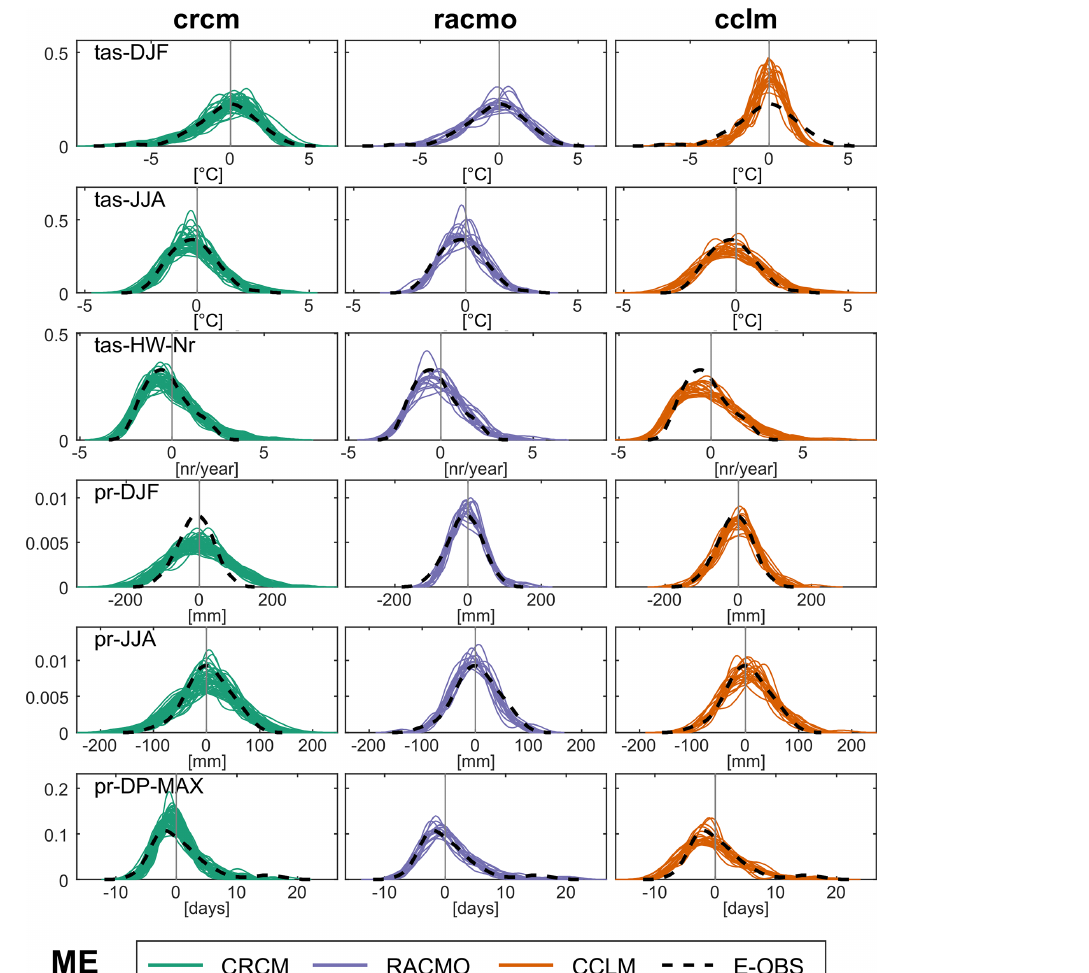
Figure 5. Probability density functions of the annual anomalies during the period 1957–2015 in E-OBS and each ensemble member for all six indicators in mid-Europe